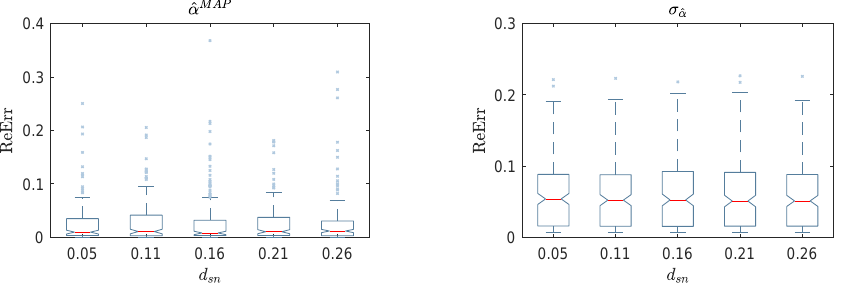
Figure 13. Box-plot of the reconstructed error (ReErr) of the identified damage location ˆ α , classi- fied based on damage severity: the MAP values ˆ α MAP ( left ); and the standard deviation σ ˆ α ( right ).